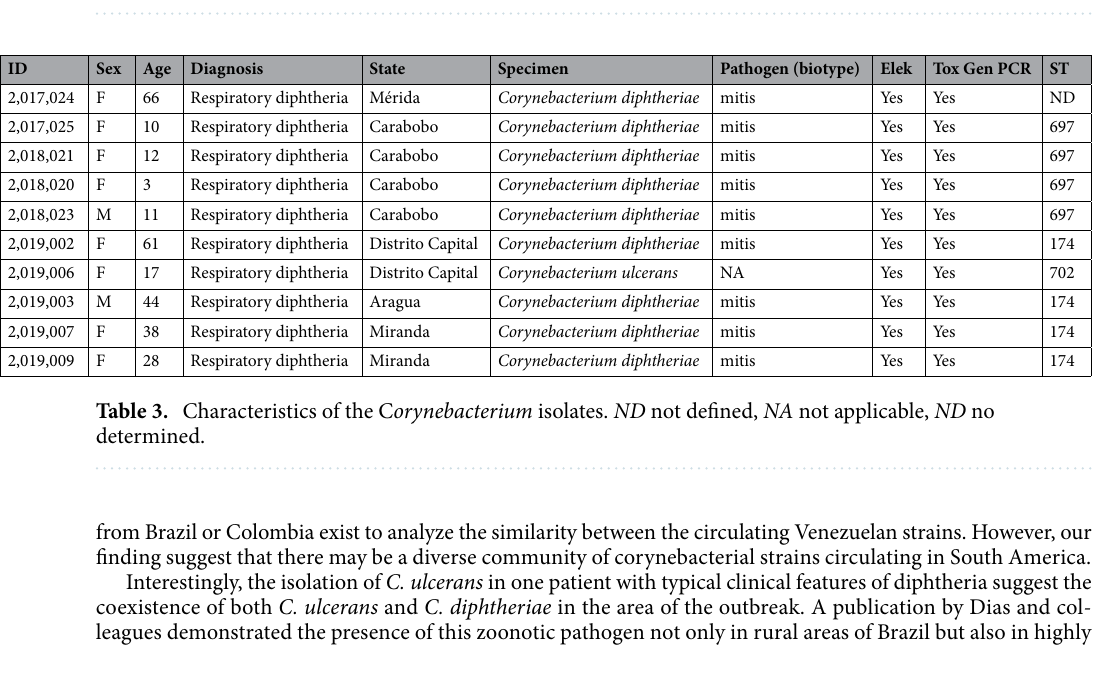
Figure 4. Minimum-spanning tree of core genome multilocus sequence typing with 1423 targets of the toxigenic Corynebacterium diphtheriae isolates from Venezuela. Allele distances between isolates are indicated, cluster with allele difference ≤ 5 is shaded in pink, and the reference genomes are shown in grey (only the reference genome used as seed and the closest reference genome to Venezuelan isolates are shown).